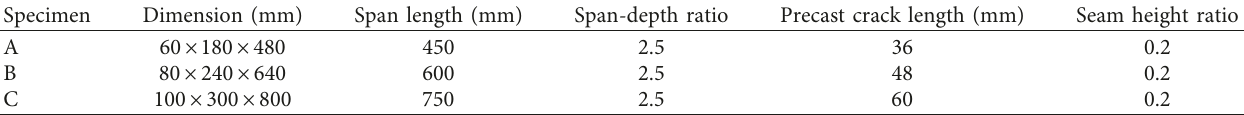
Table 9: Detailed information of